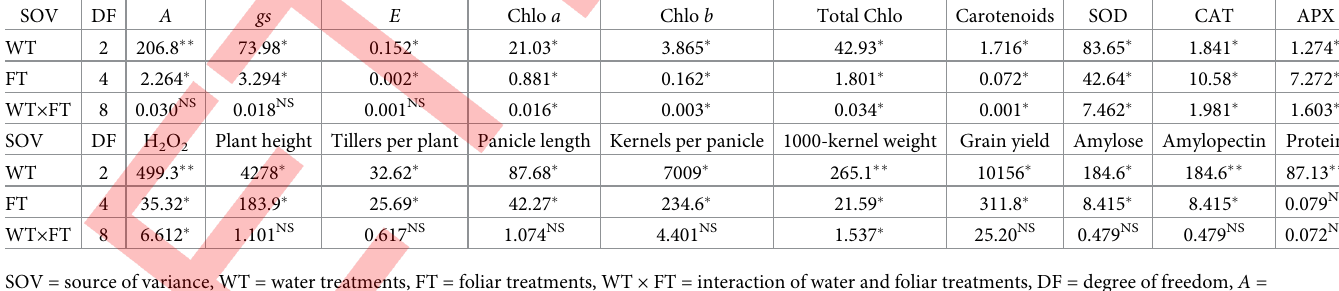
Table 1. Analysis of variance for gas exchange, physiological, enzymatic, agronomic, yield and quality attributes of rice plants cultivated under different levels of drought stress and foliar application of moringa leaf extract (n = 4). SOV